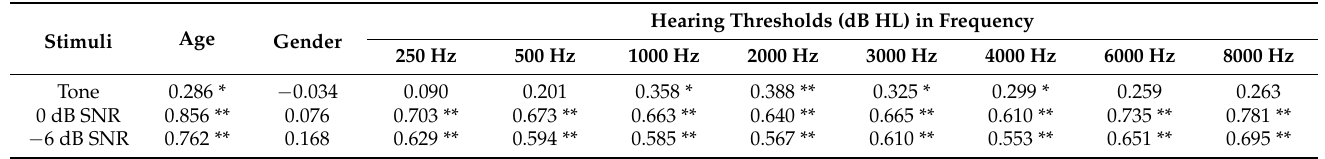
Table 2. Results of the Pearson correlation for listening effort and inherent variables for three conditions. Stimuli